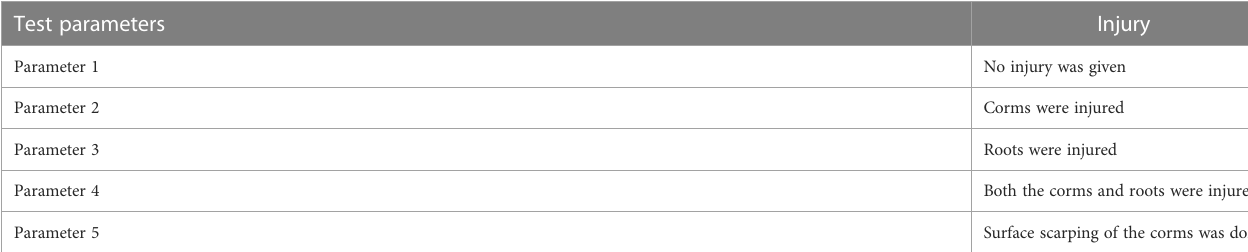
TABLE 1 Injury parameters selected for the pathogenicity test of the fungal isolates. Test